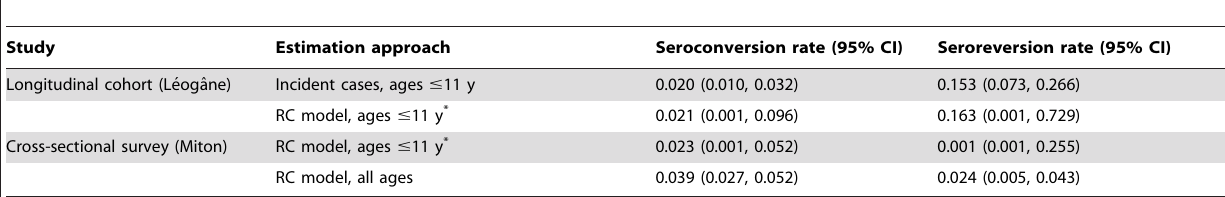
Table 3. Comparison of seroconversion and reversion rates calculated from different study cohorts and different estimation